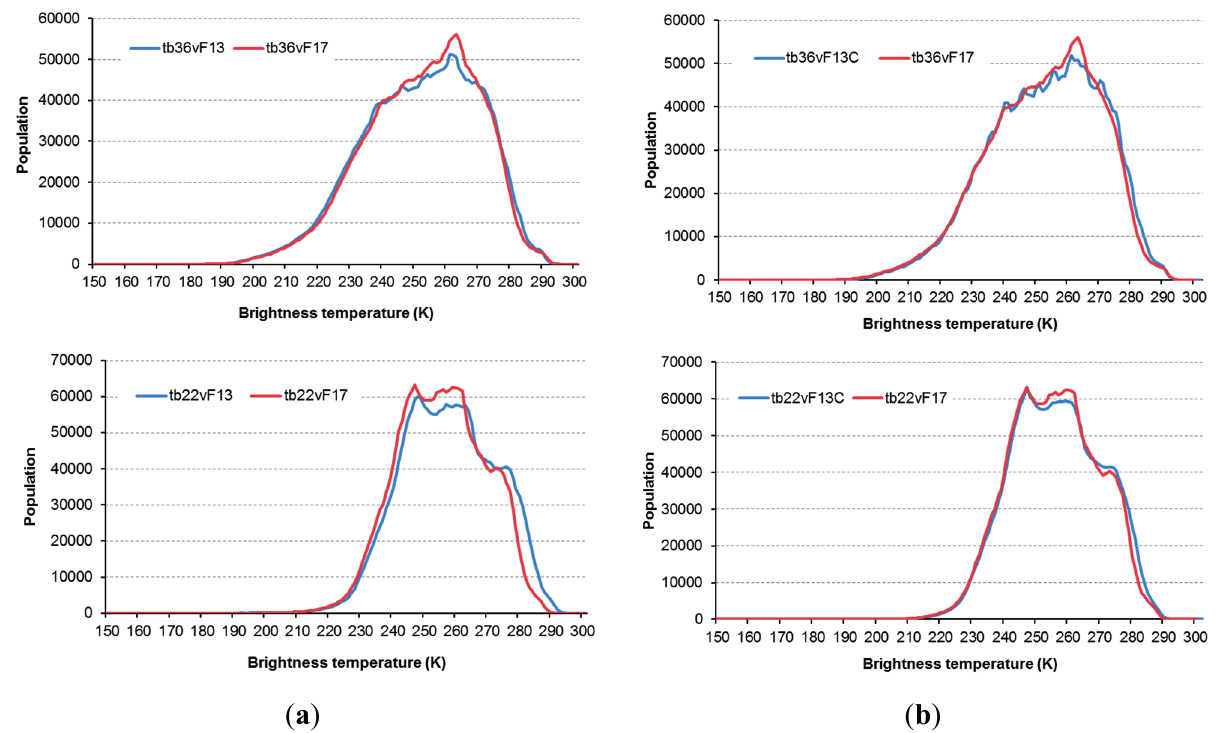
Figure 2. Original and calibrated F13 SSM/I and F17 SSMI/S Tb histograms in the overlap period (from 1 January to 1 April 2008) for each channel for China: ( a ) F13 and F17; and ( b ) F13C and